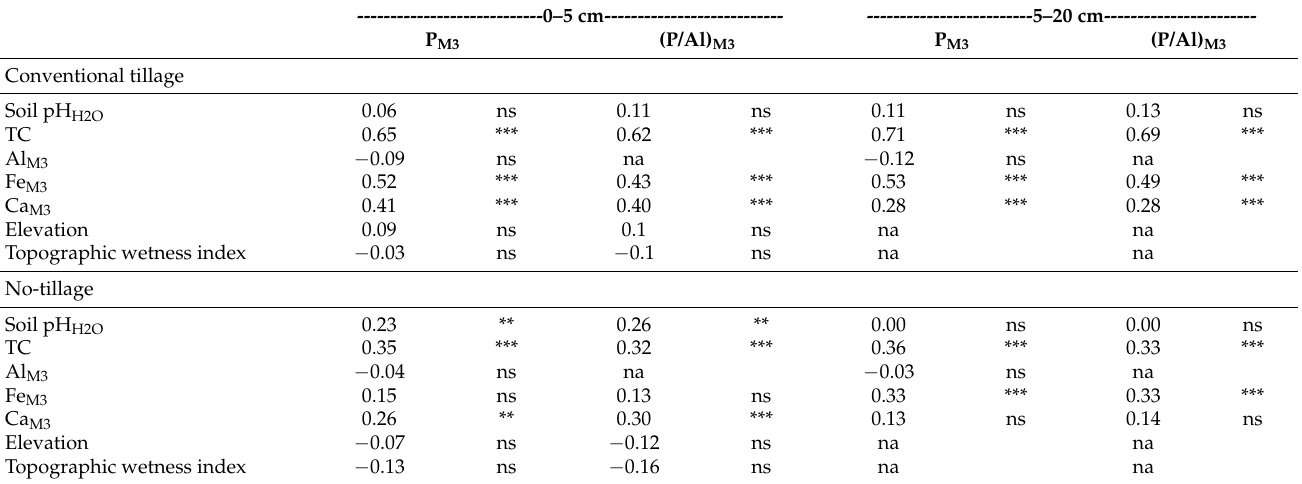
Table 3. Spearman correlation coefficients of the soil-available phosphorus indices (P M3 ) and (P/Al) M3 in relation to soil chemical and topography properties for two soil layers (0–5 cm and 5–20 cm) in the conventional and no-tillage fields.